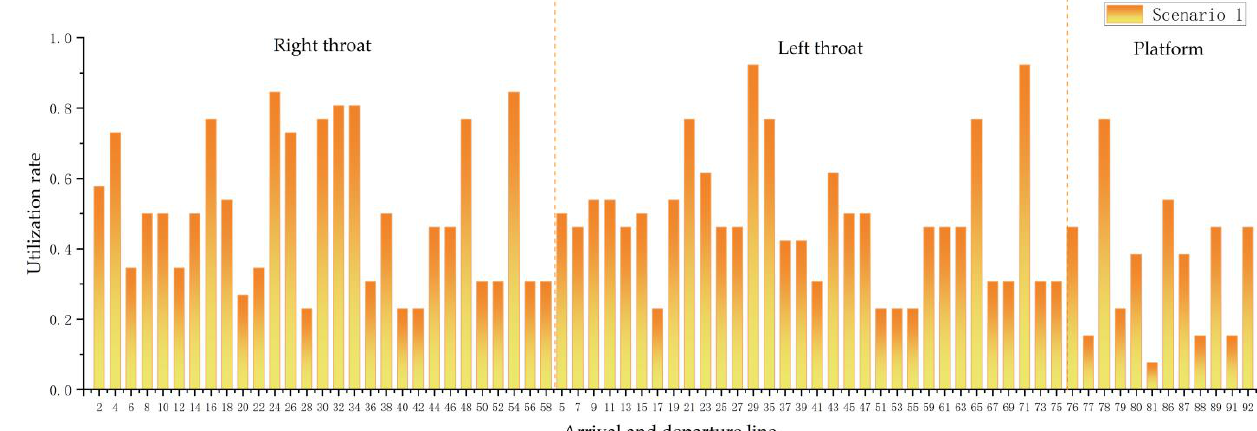
Figure 8. Utilization of switches and platforms in scenario 1.